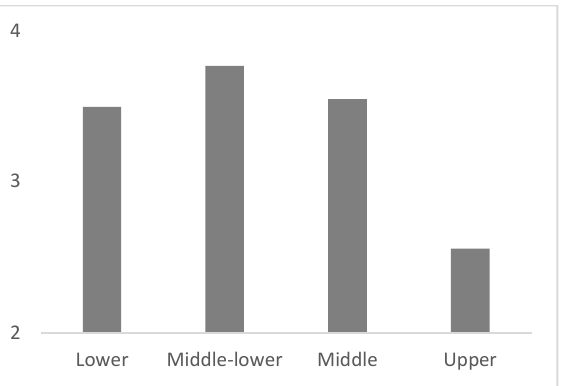
Figure 3. Average degree of teachers’ agreement with the statement “The lack of technological means in the students is a limitation”, according to the socio-economic status of students.